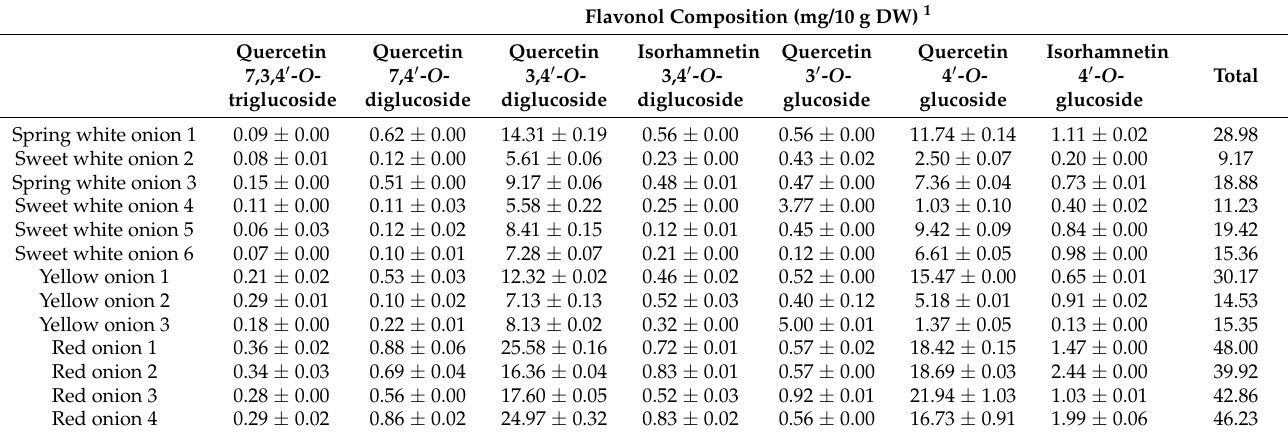
Table 5. Quantification of flavonols in white, yellow, and red onion varieties.